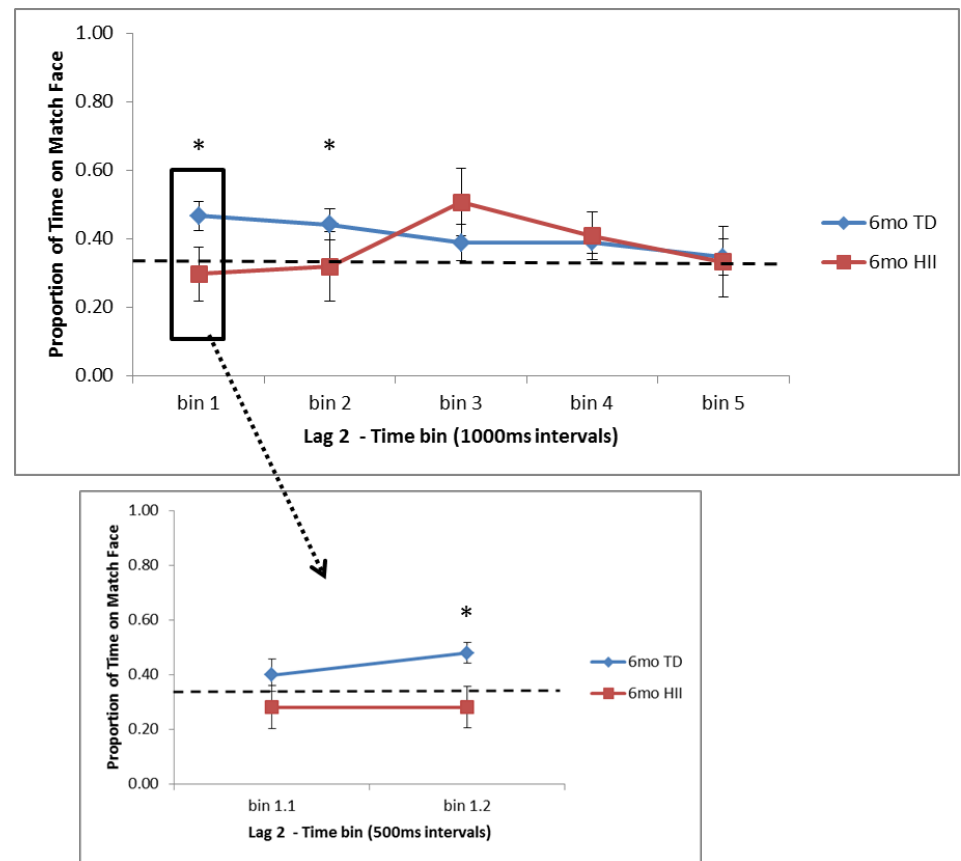
Figure 3. Proportion of time fixating the matching face for Lag 2 trials for the five 1000 ms time bins (bins 1–5) and the two 500 ms bins in the first 1000 ms (bins 1.1 and 1.2) for 6-month-old typically developing infants (TD) and hypoxic–ischemic injured infants (HII). Looking to the match face was significantly higher than expected by chance for 6-month TD infants in bins 1 (0–1000 ms) and 2 (1000–2000 ms) as well as in bin 1.2 (500–1000 ms). Chance is illustrated with a dashed line; error bars indicate the standard error of the mean. * p < 0.05.